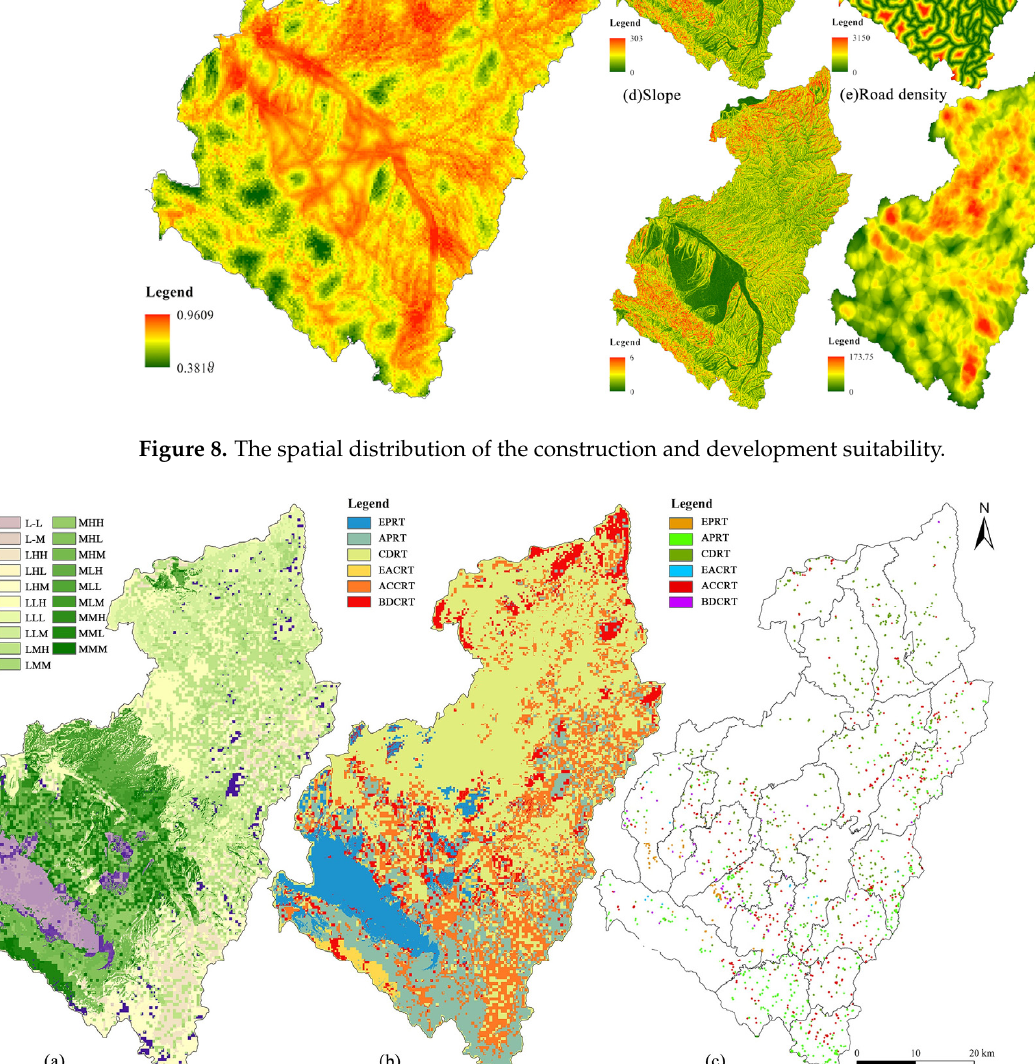
Figure 8. The spatial distribution of the construction and development suitability.